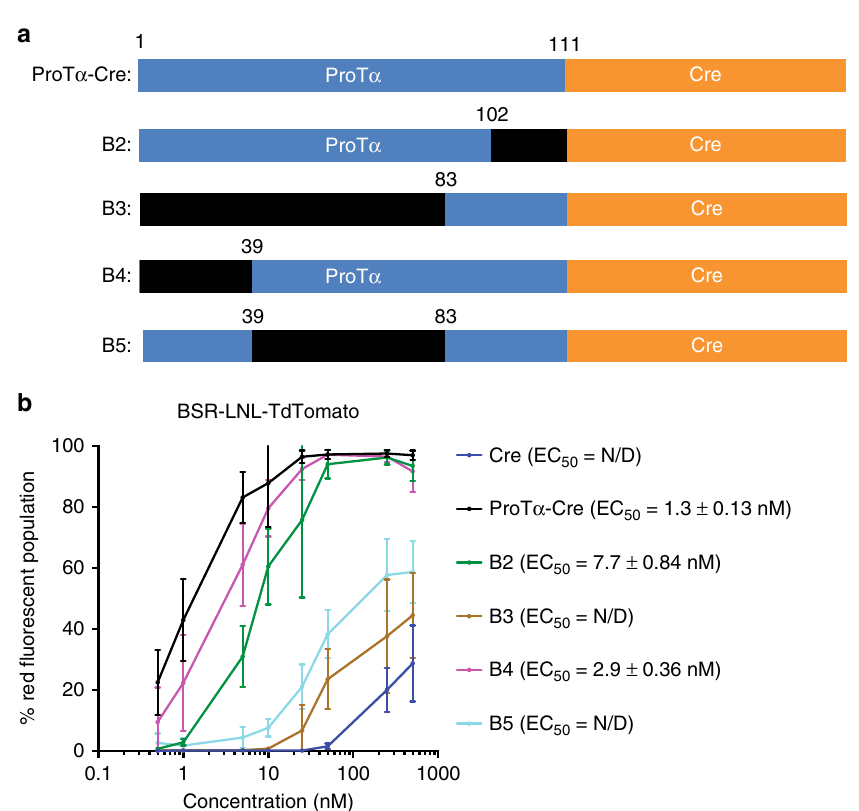
Fig. 3 Truncation of ProT α . a Primary structure of several truncated variants of ProT α -Cre. Deleted regions are shown in black. b Lipid-mediated delivery ef fi ciency of Cre fused to each truncated ProT α variant into the BSR-TdTomato cell line. Removal of the central region containing stretches of acidic residues (B3, B5) results in a >100-fold reduction in protein delivery potency. Deletion of either the N-terminus or the C-terminus of ProT α (B4, B2) also reduces delivery ef fi ciency, suggesting that the termini also play a role in the delivery process. EC 50 is de fi ned as the protein concentration at which 50% of analyzed cells contain red fl uorescence. Values and error bars represent the mean and standard deviation of three independent biological replicates performed on different days. EC 50 values were determined by nonlinear fi t to the Hill equation, and are followed by the standard errors of the fi t. Source data are available in the Source Data fi